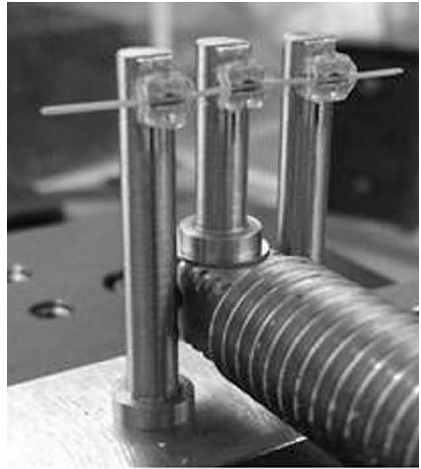
Figure 10. Elastomeric ligature.